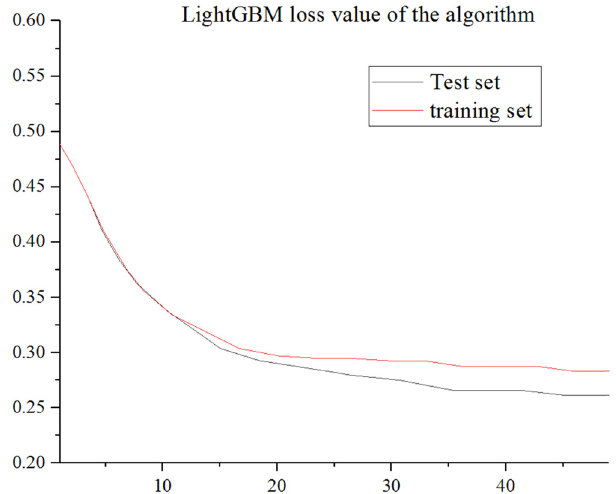
Figure 4: Loss value of LightGBM